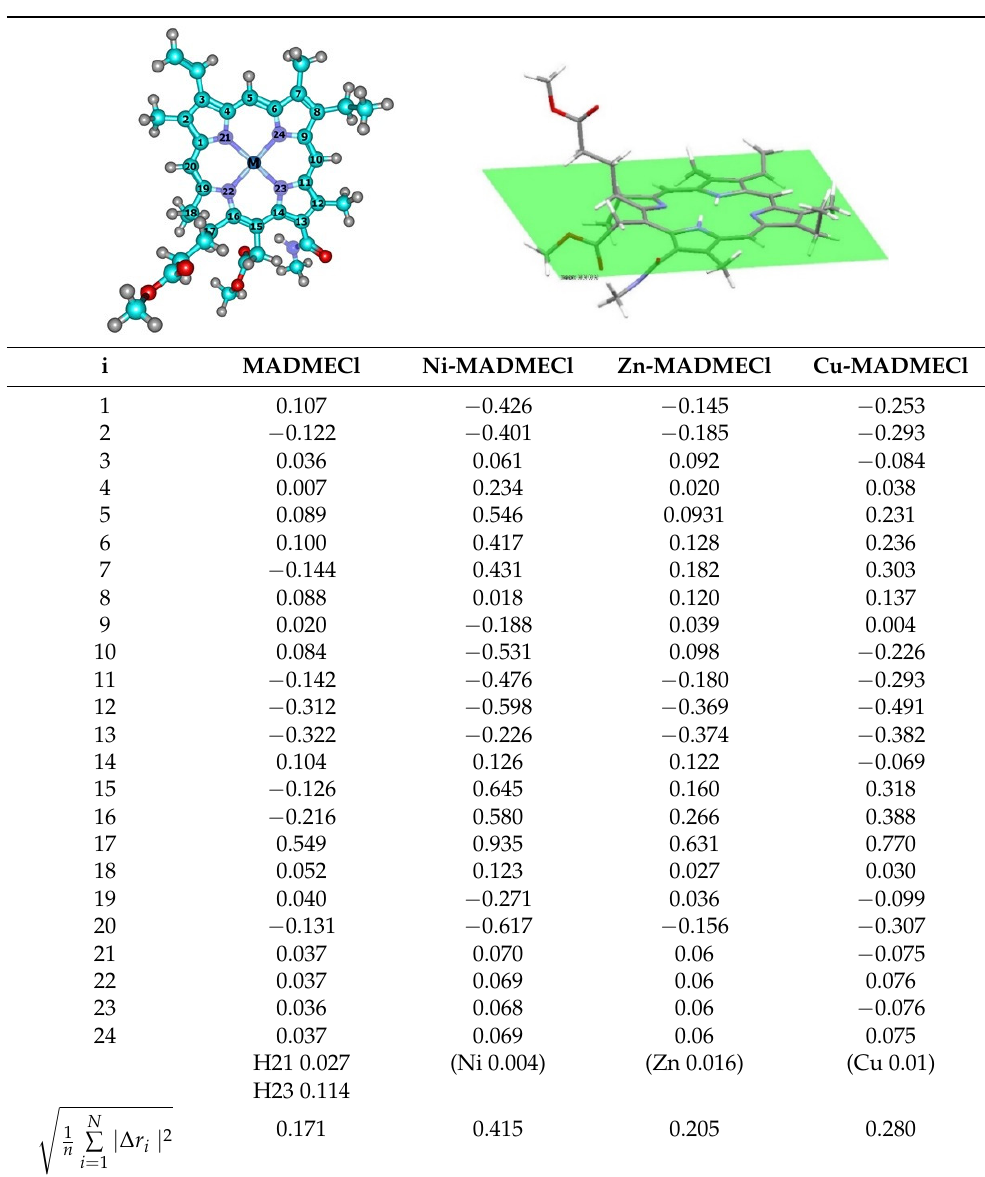
Table 1. Distances from individual atoms (Ri, Å) to the averaged NNNN plane according to CAM- B3LYP/6–31 g(d,p) data.